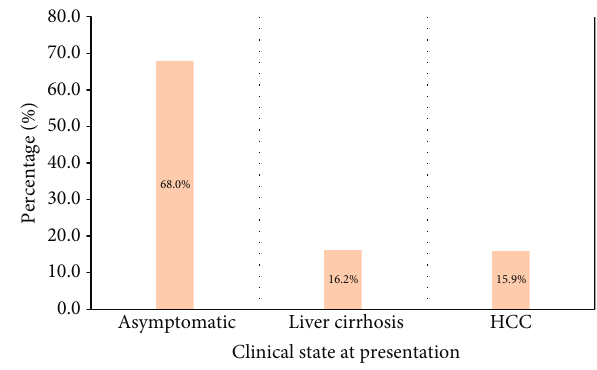
Figure 1: Clinical state at presentation of newly diagnosed chronic HBV